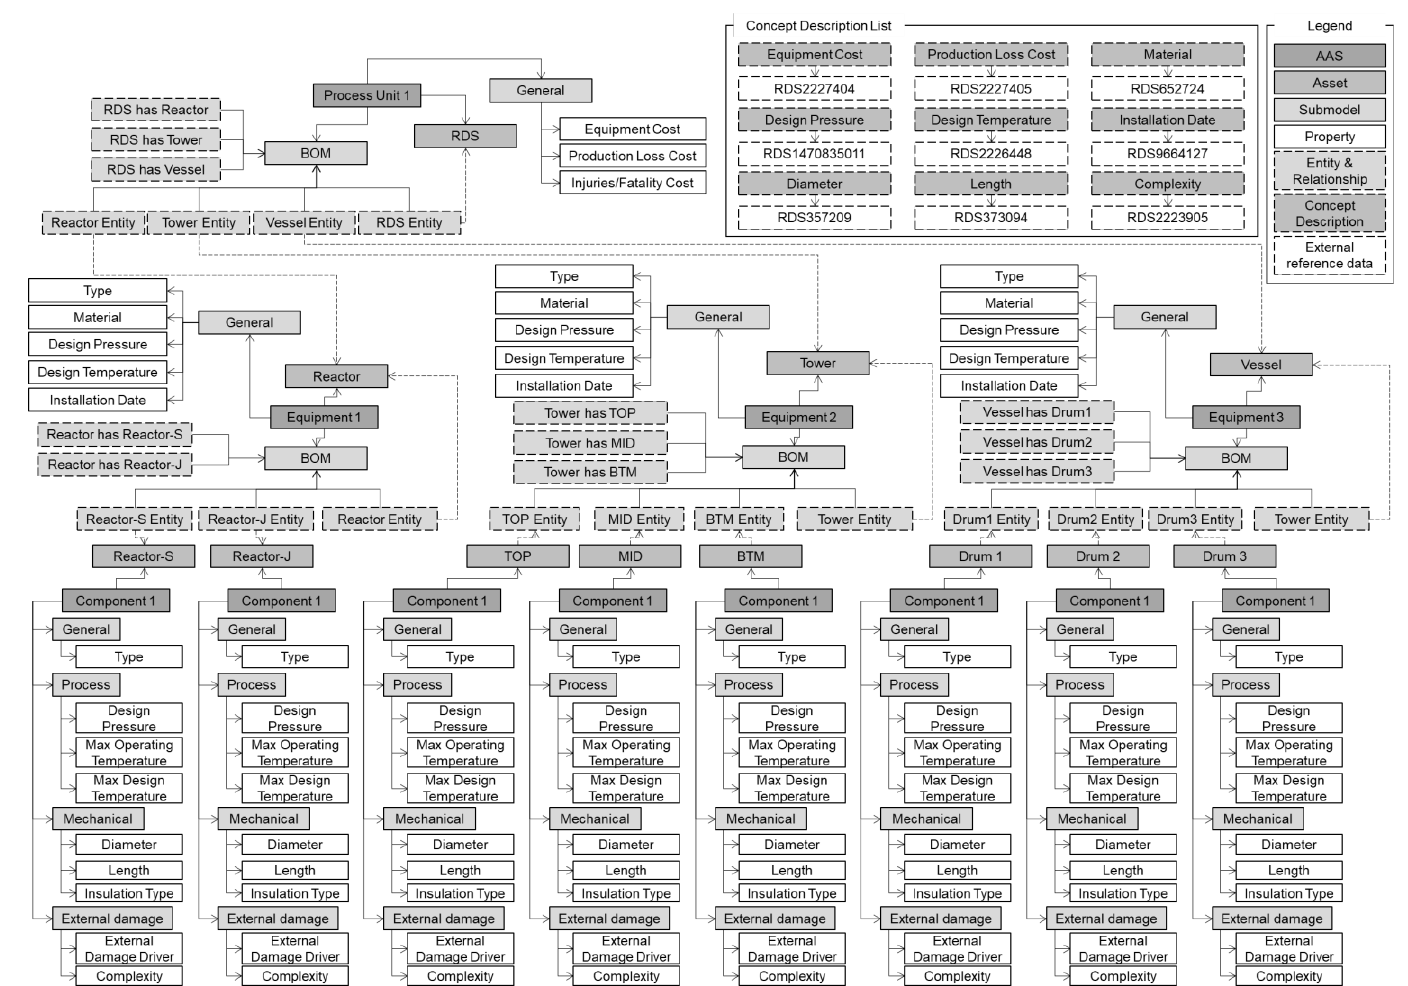
Figure 11. AAS configuration based on the neutral equipment maintenance data model for the RDS process used in the experiment.